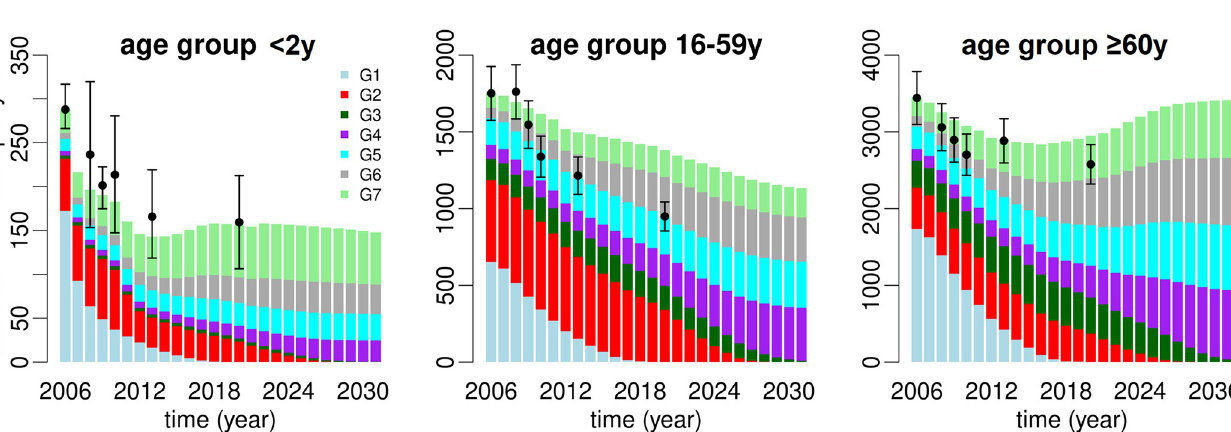
PLOS ONE | https://doi.org/10.1371/journal.pone.0281261 February 15,